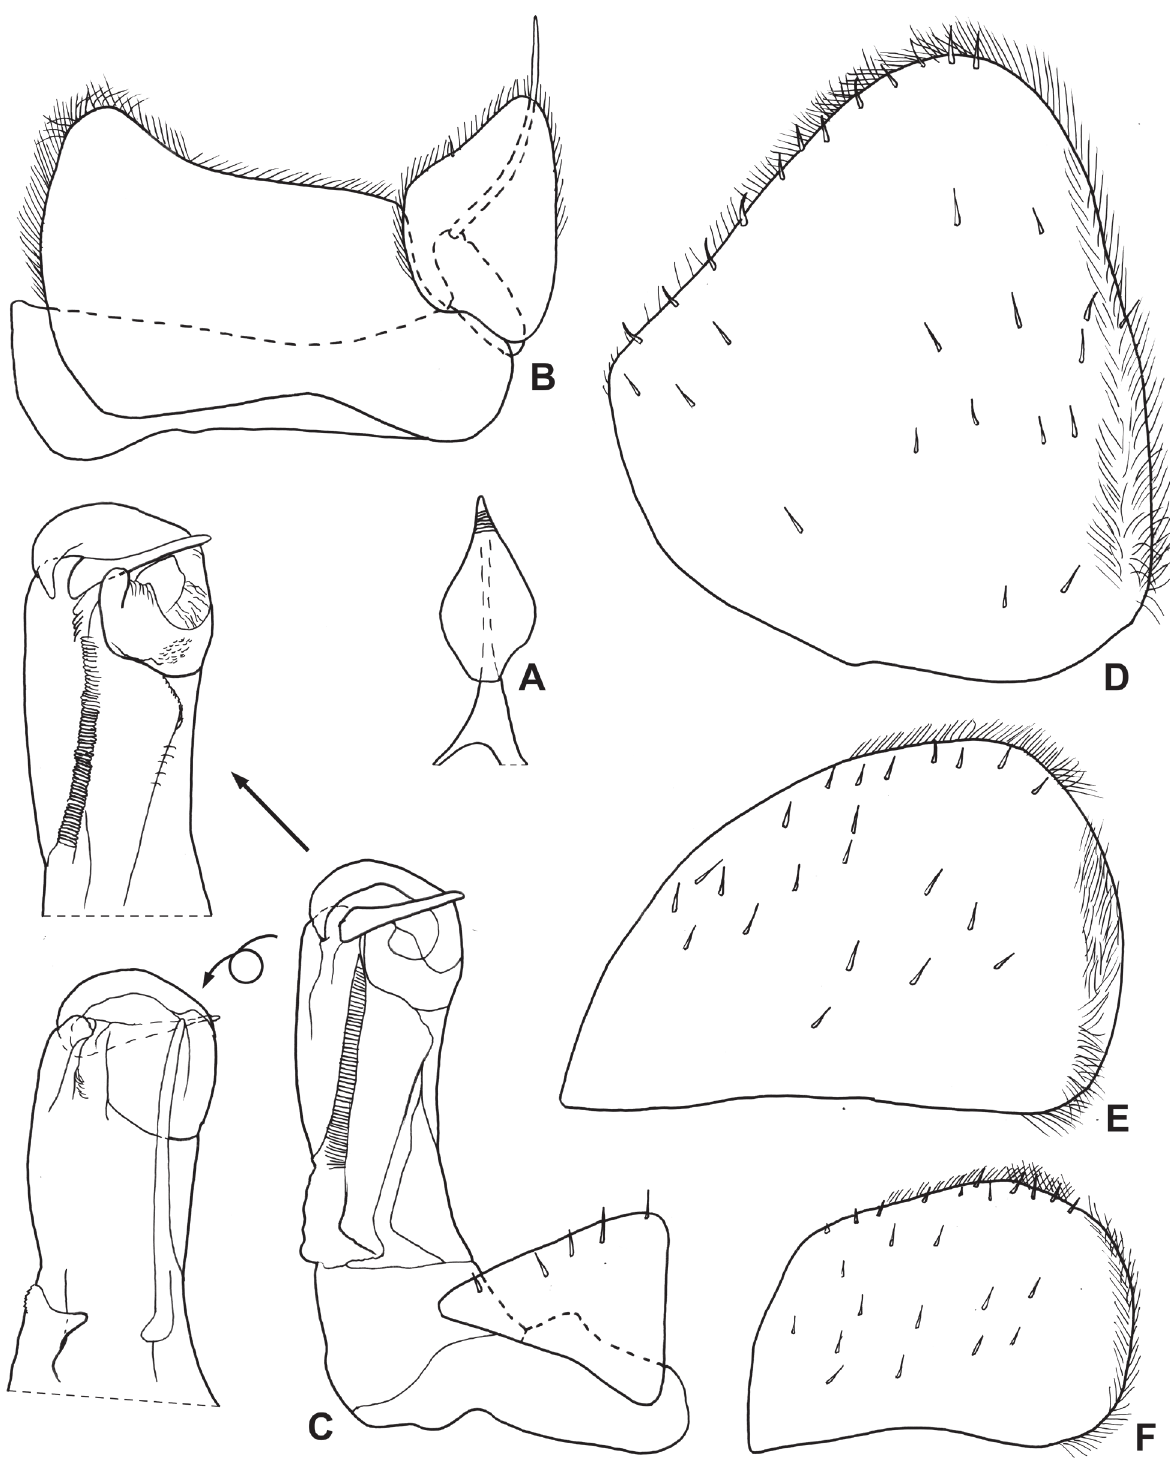
Figure 6. Xangoniscus odara n. sp. (male paratype). A, genital papilla; B, pleopod 1; C, pleopod 2; D, pleopod 3 exopod; E, pleopod 4 exopod; F, pleopod 5